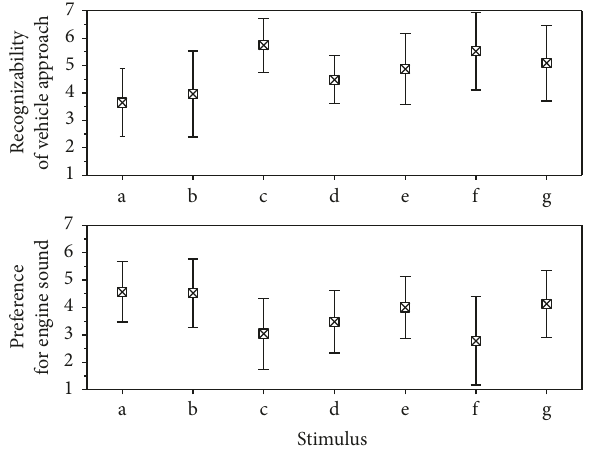
Figure 9: Results of the auditory experiments to evaluate the recognizability of vehicle approach and preference for engine